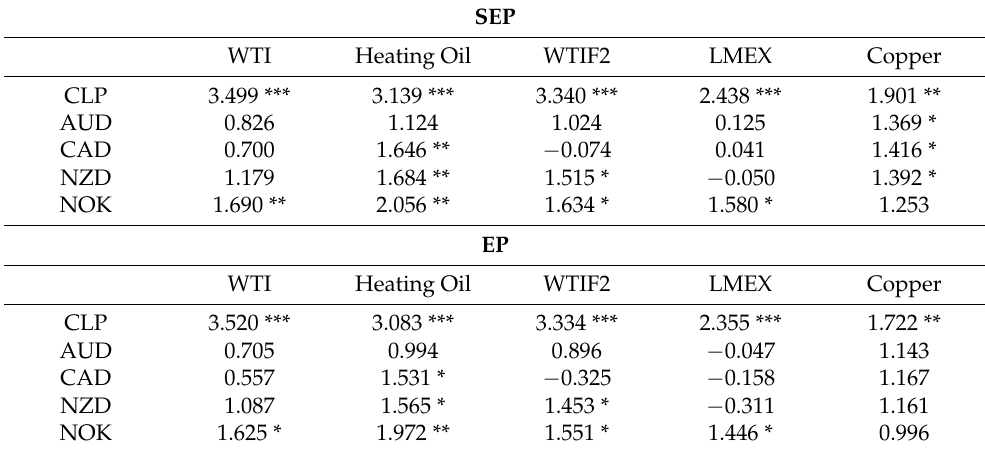
Table 10. Empirical Illustration Forecasting Commodity Prices with Commodity